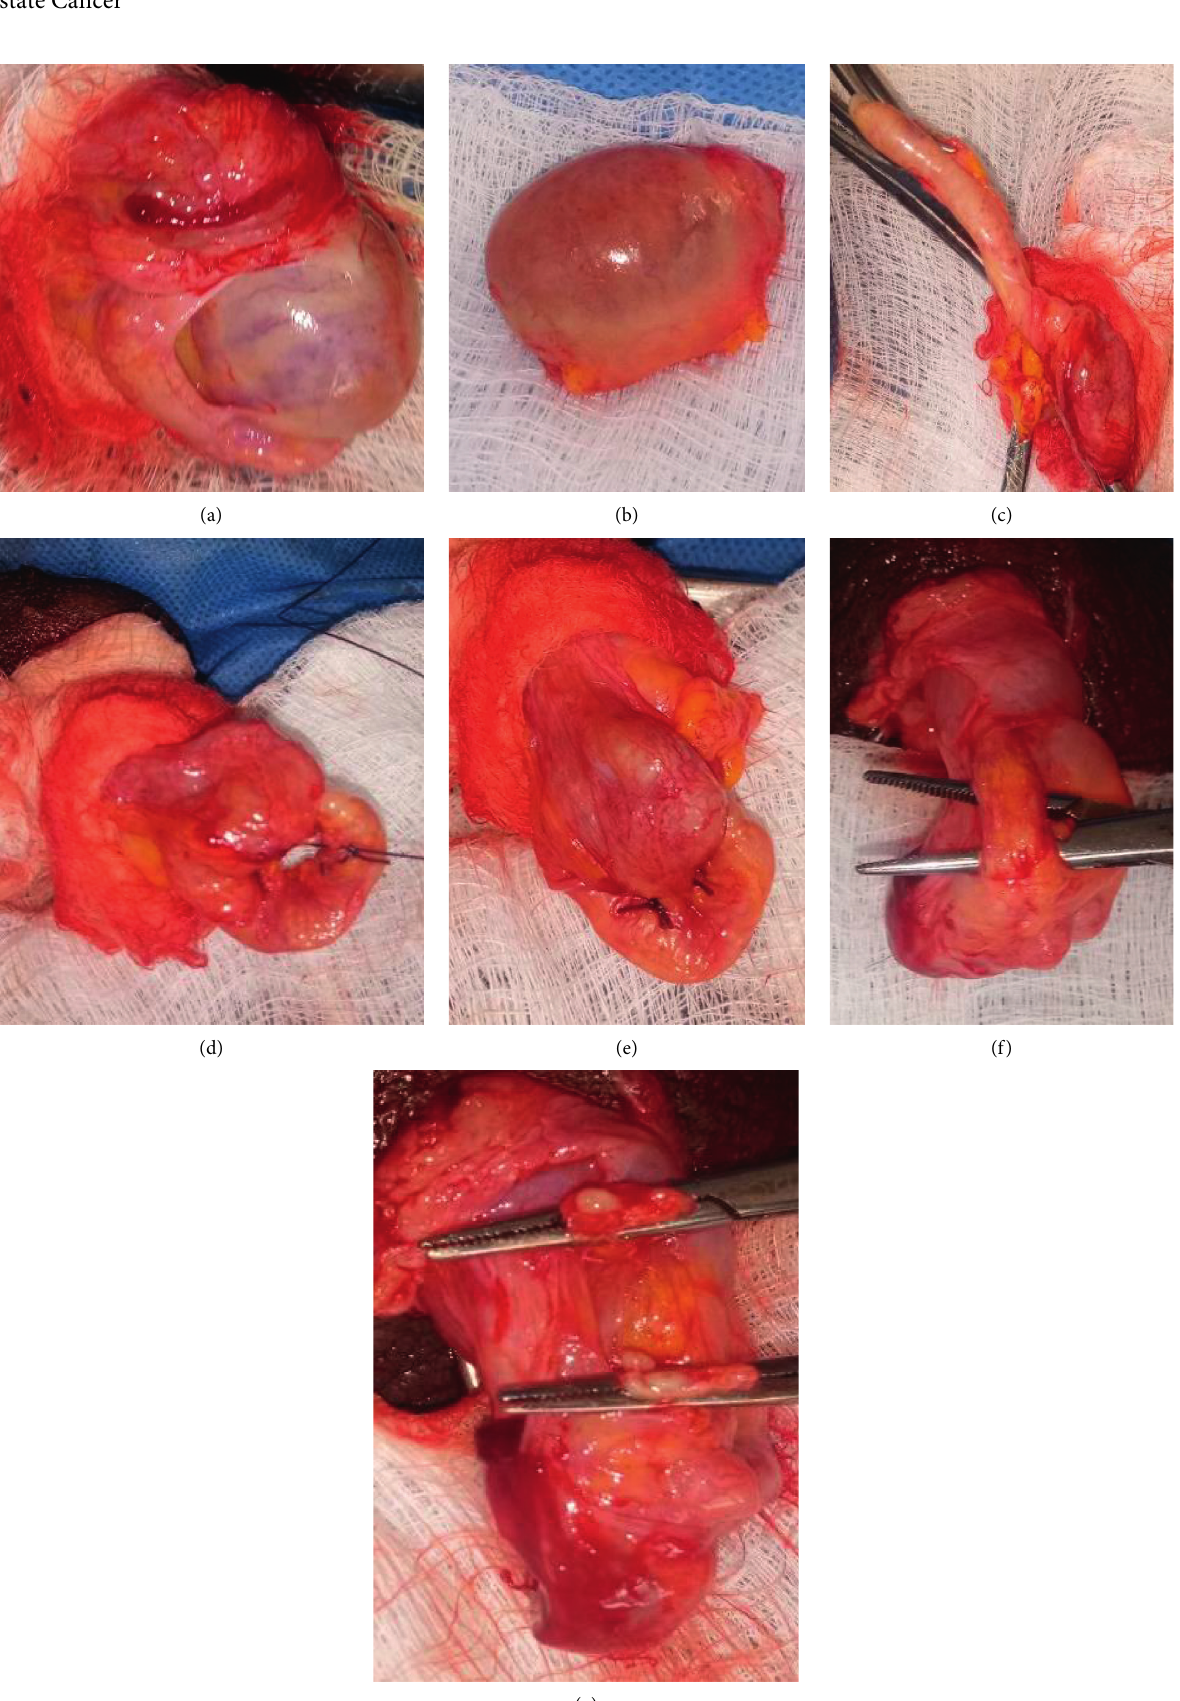
Figure 3: Epididymal-sparing orchidectomy. (a) Developed epididymal sinus. (b) Excised testis. (c) Isolated epididymis to be used as pseudotesticle. (d) Cauda of epididymis looped to meet the caput.(e) Epididymal pseudotesticle. (f) Isolated vas deferens. (g) Division of